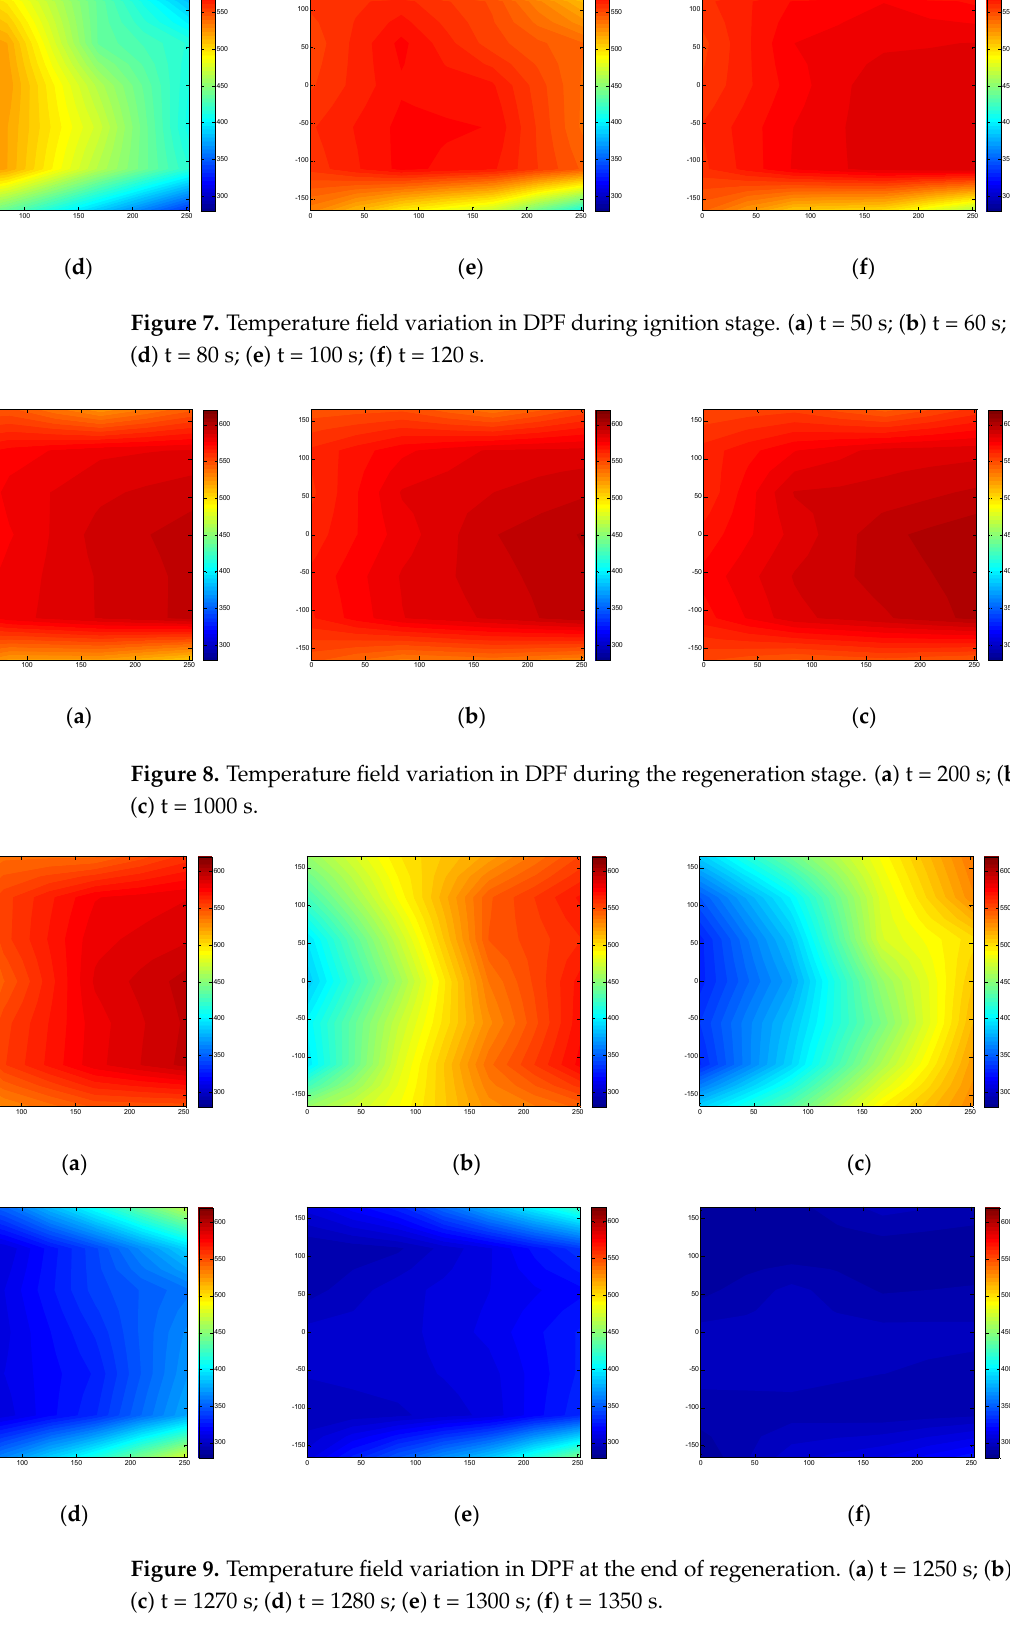
Figure 9. Temperature field variation in DPF at the end of regeneration. ( a ) t = 1250 s; ( b ) t = 1260 s; ( c ) t = 1270 s; ( d ) t = 1280 s; ( e ) t = 1300 s; ( f ) t = 1350 s. Safe Regeneration with Different Carbon Loading Levels To investigate the safe regeneration temperature and the distribution of the peak temperature of a DPF at different carbon-load levels, an experimental study was per- formed by simulating the DTI regeneration process on an engine bench. In the experiment, the regeneration temperature of a DPF was taken at 25 °C intervals from 550 to 650 °C, the carbon load was based on the theoretical carbon-load limit (SML) of 9 g/L, and the meas- urement points were designed at 30% to 150% SML with equal intervals. The design of the selected test points is shown in Table 4. In general, an excessive DPF carbon load should be avoided at high regeneration temperatures to prevent the DPF from being burned frequently, which would affect the test progress [31–37]. At the beginning of each test point, the DPF is regenerated thoroughly, and then, the DPF is loaded with soot par- ticles under specific conditions until the desired carbon-loading level is reached. After the constant temperature treatment, the DPF was weighed by a high-precision electronic bal- ance to obtain the initial carbon load of the DPF. In the test, the engine is first adjusted to the target operating condition (speed = 2350 r/min, torque = 80 N•m); the DPF is then triggered to regenerate actively; and the throttle position is reset immediately when the DPF inlet exhaust temperature reaches the set regeneration temperature so that the engine runs at idle speed. Thereafter, the DPF internal temperature field stabilizes, and the test is